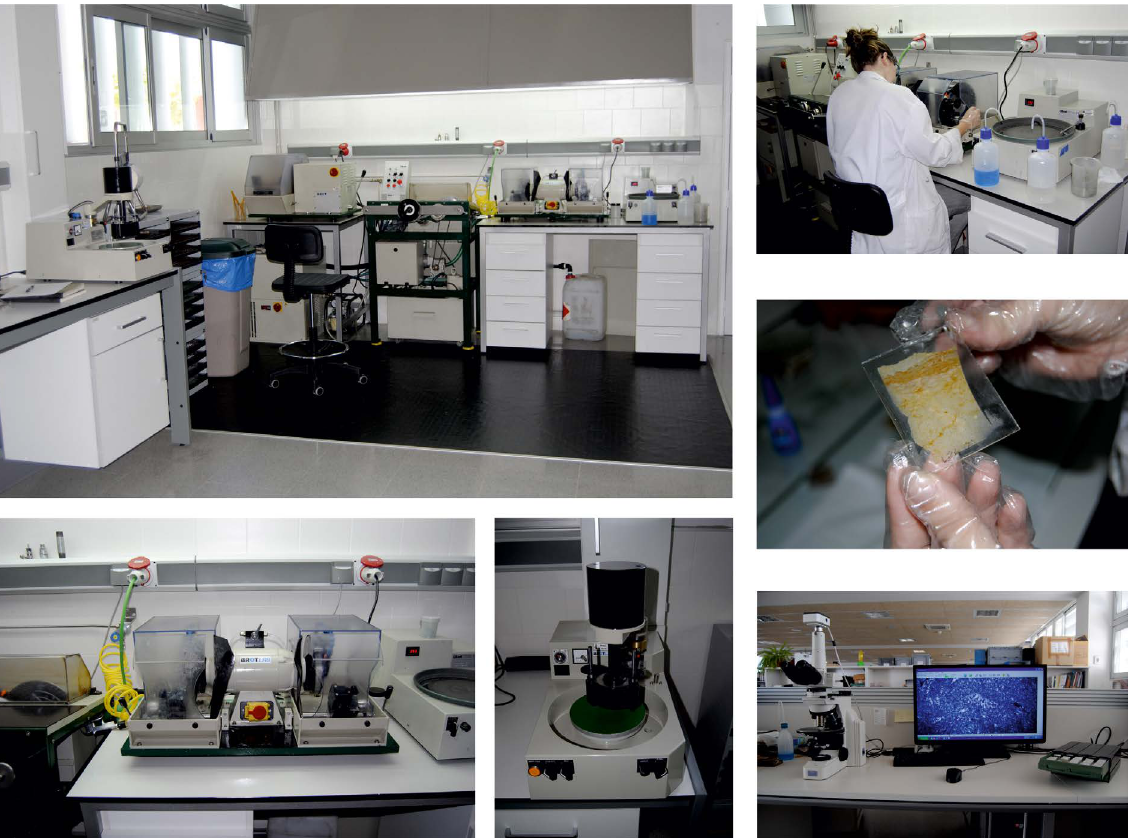
Figure 2. Thin-section and analysis equipment at the Geoarchaeology facilities at